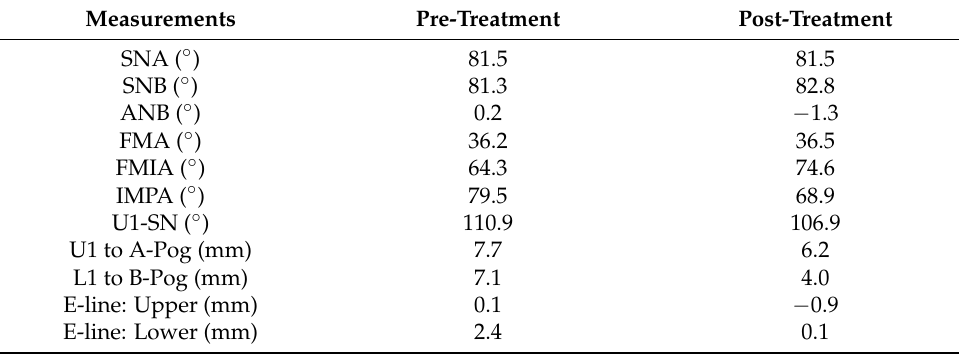
Figure 3. Pre-treatment panoramic radiograph. Table 2. Summary of cephalometric